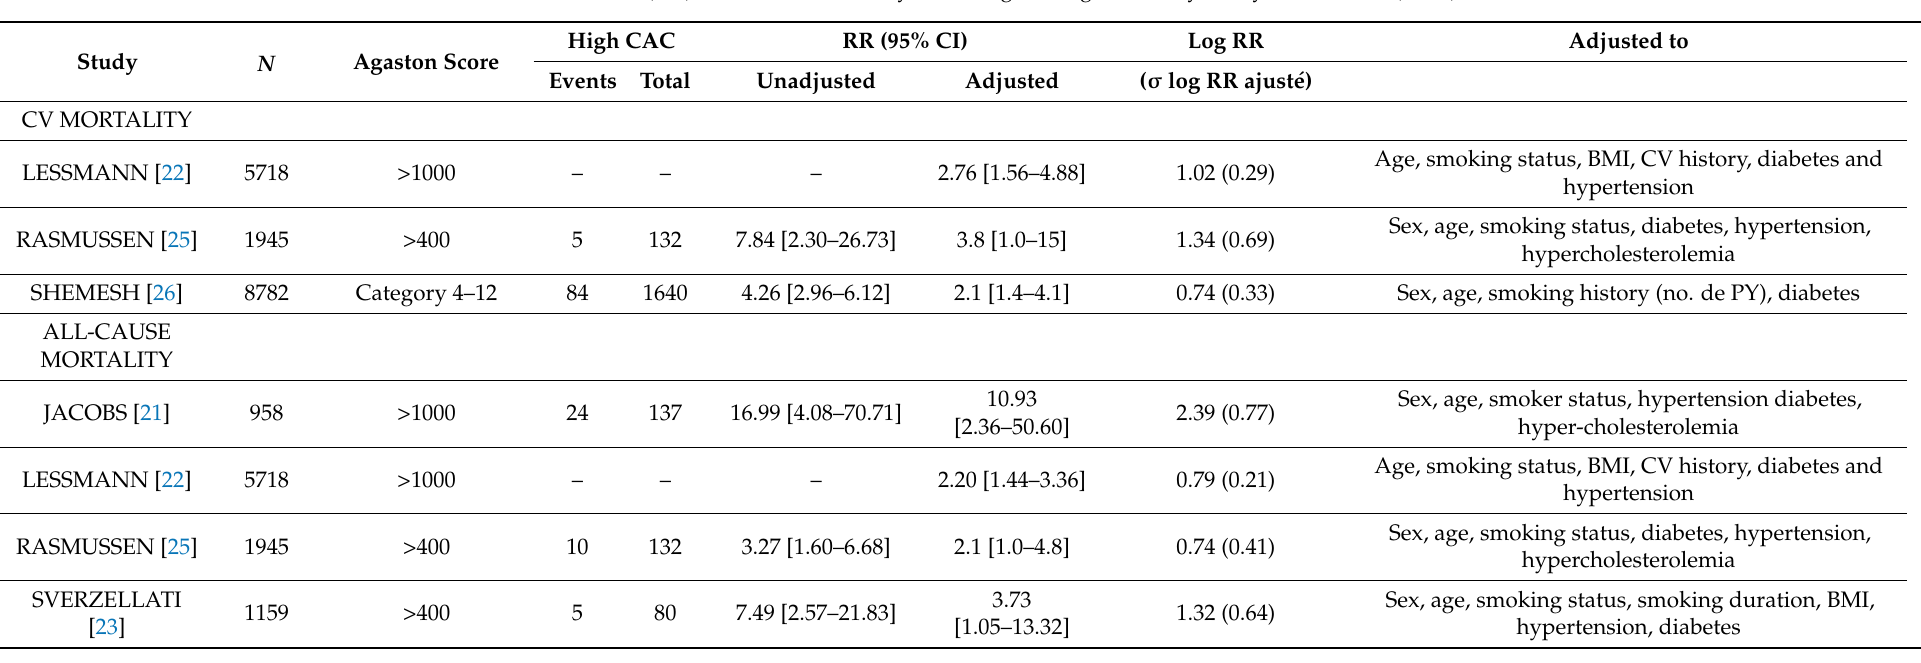
Table 3. Cardiovascular (CV) or all-cause mortality according to a high coronary artery calcification (CAC)